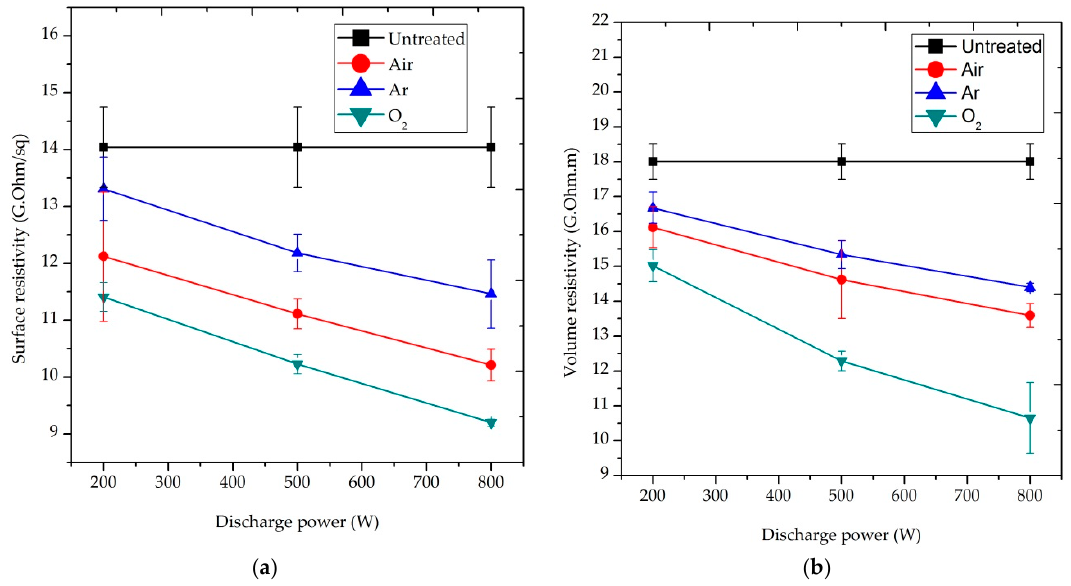
Figure 4. Effect of discharge power on: ( a ) surface resistivity ( ρ s ) and ( b ) volume resistivity ( ρ v ) of P/C blend fabric.